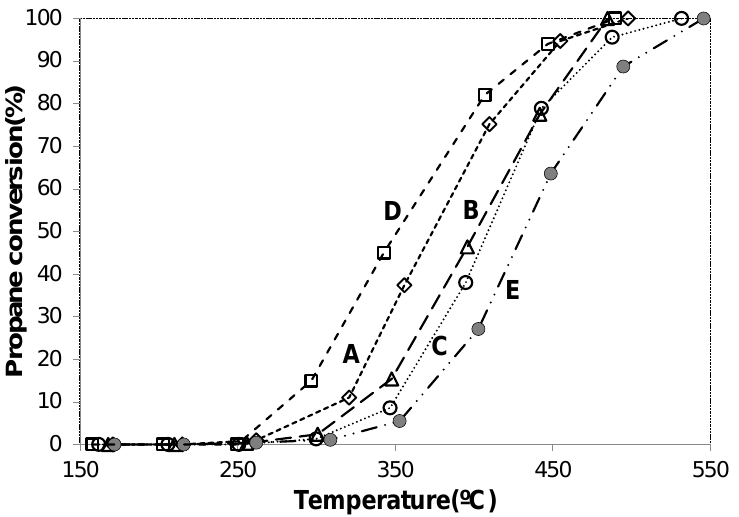
Figure 8. Propane conversion to CO 2 vs. temperature. (A) PdCo-ZnAl; (B) PdCu-ZnAl; (C) Pd-ZnAl; (D) Co-ZnAl; (E) Cu-ZnAl.